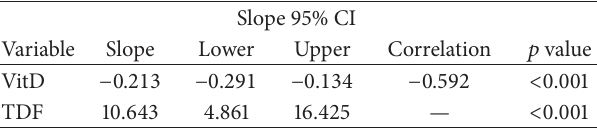
Table 3: Linear Mixed Model, PTH dependent